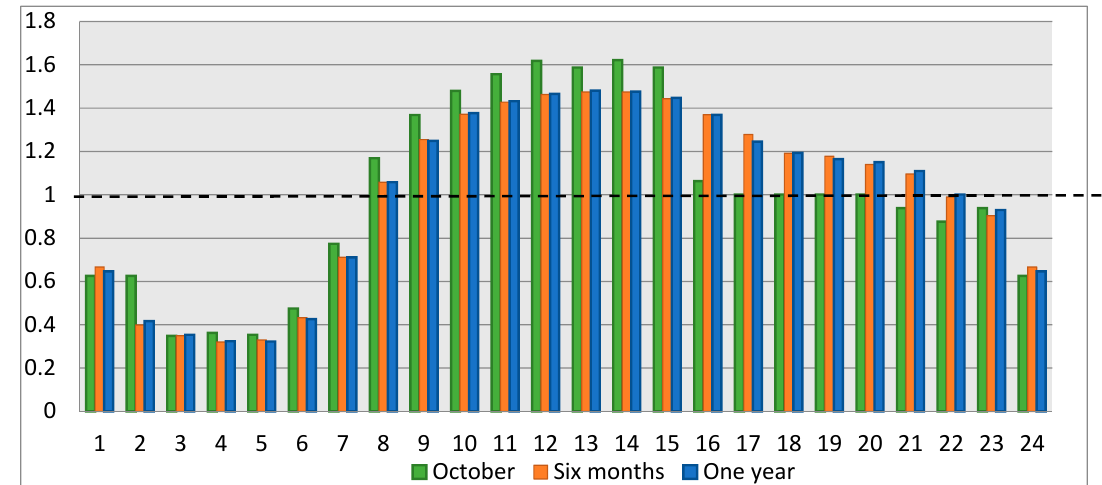
Figure 16. Simulation results for Scenario